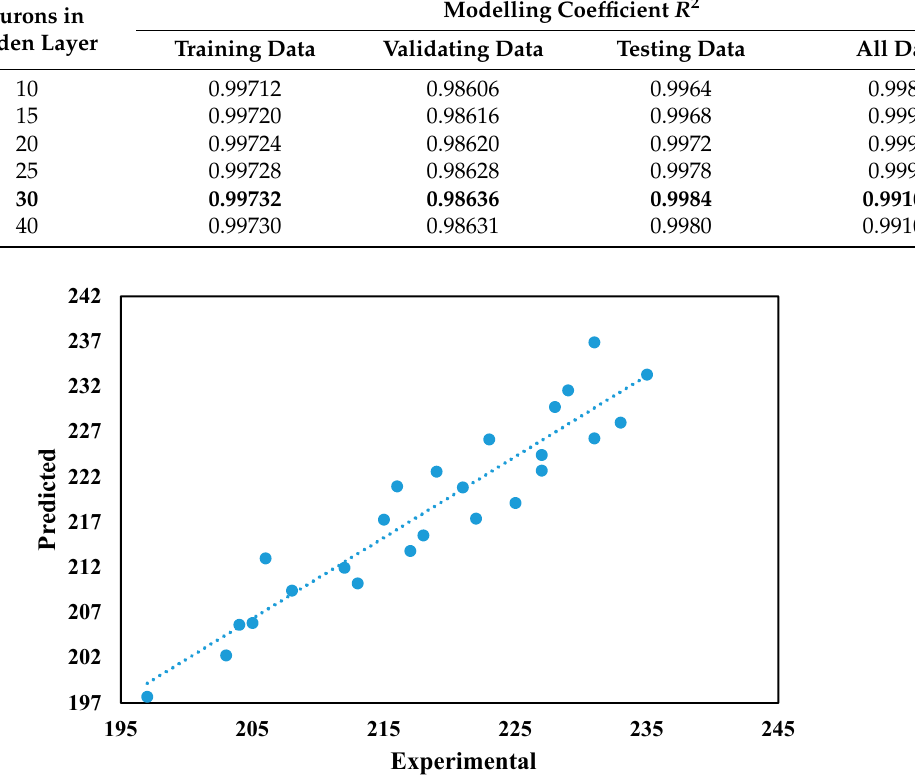
Figure 25. ANN modelling results vs. experimental results (UTS). Table 9. ANN predictions for